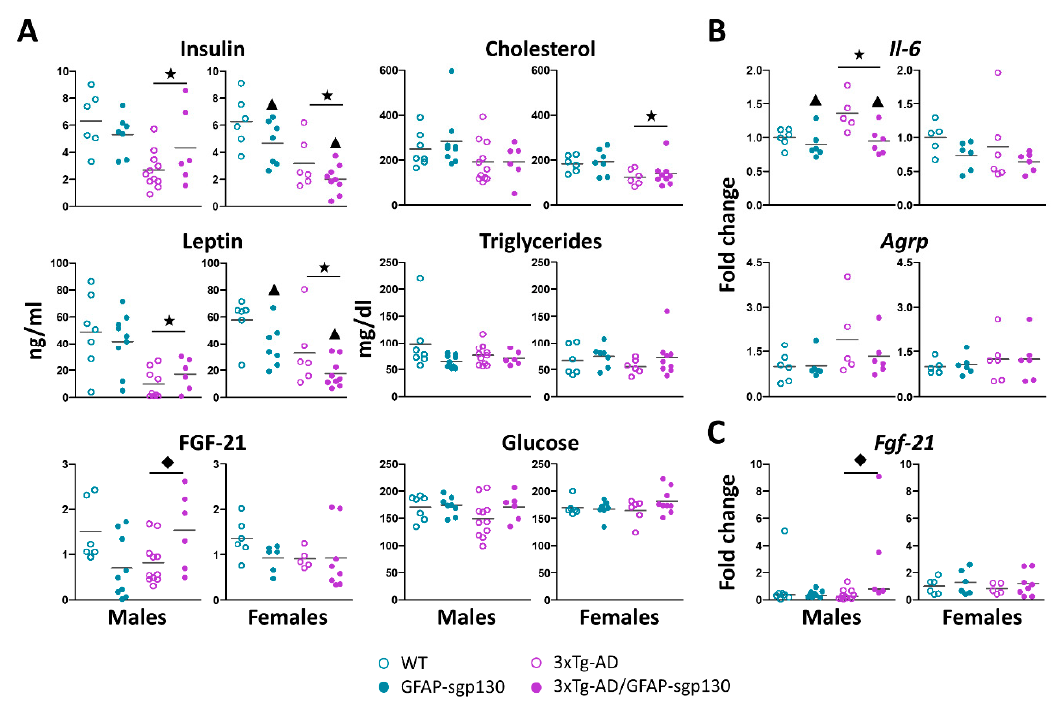
Figure 4. Hormones and metabolites in serum. Hypothalamic and liver gene expression after HFD. ( A ) Generally, 3xTg-AD mice showed lower serum levels of insulin, leptin and cholesterol. Blocking of IL-6 trans-signaling decreased insulin and leptin levels in 3xTg-AD and control females and increased Fgf-21 levels in 3xTg-AD males. ( B ) Il6 expression in the hypothalamus was increased in 3xTg-AD males; and this effect was rescued by the presence of sgp130Fc. No differences were seen in the orexigenic Agrp . ( C ) Fgf21 expression in the liver was increased by the inhibition of IL-6 trans- signaling in 3xTg-AD males; no effects were observed in females. Results are MEAN ± SEM. ★ p ≤ 0.05 vs. 3xTg-AD negative; ▲ p ≤ 0.05 vs. sgp130Fc negative; ◆ Indicates a significant interaction between both factors.